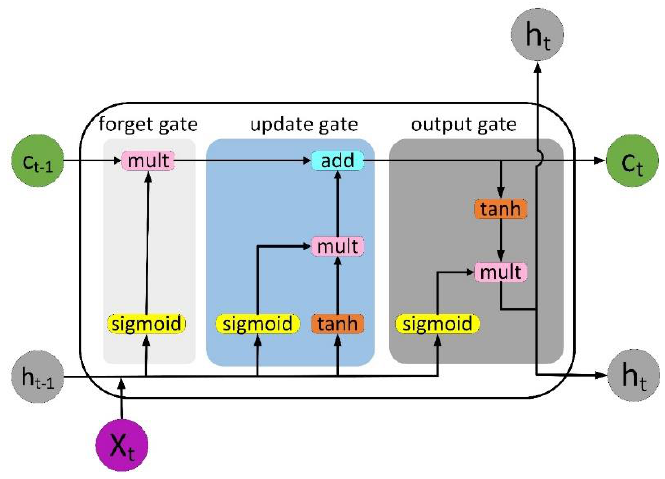
Figure 3. The internal structure of LSTM.